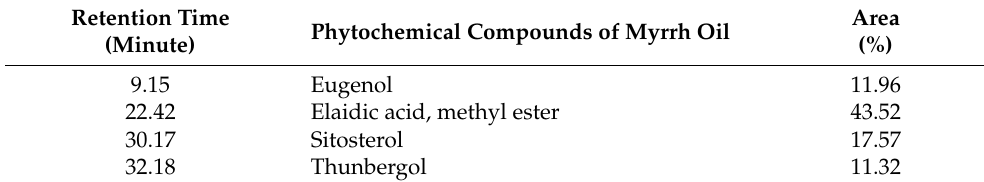
Table 1. Phytochemical analysis of myrrh